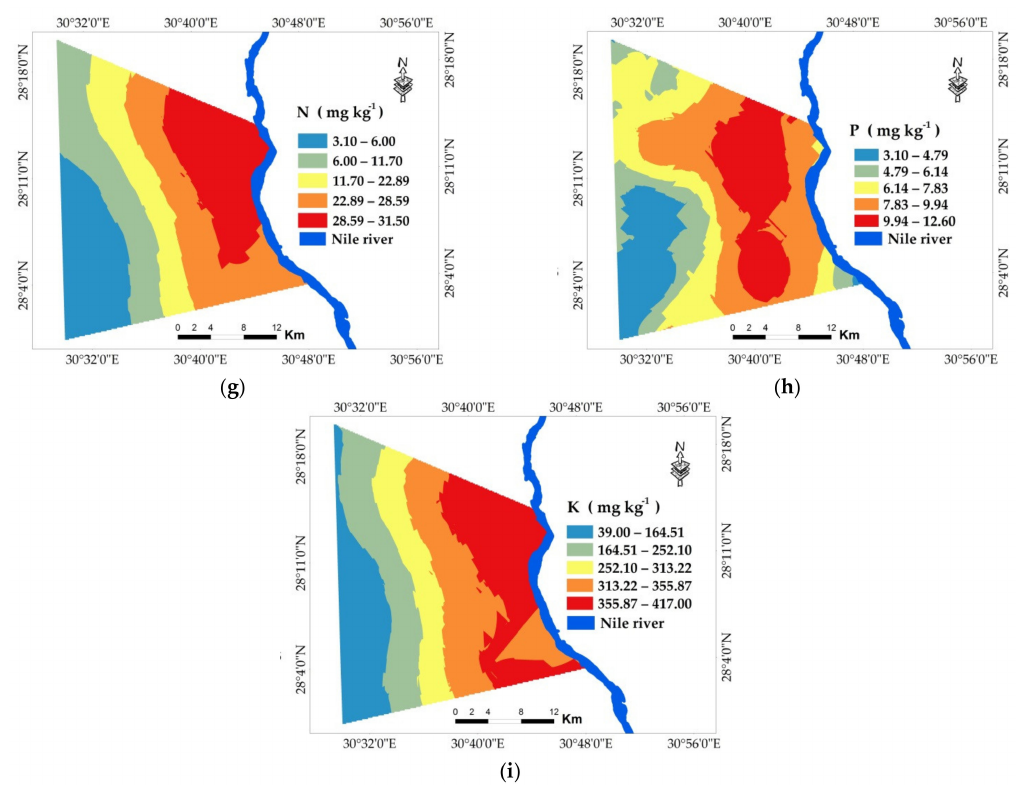
Figure 7. Interpolated maps of some mean weighted soil properties: ( a ) soil salinity (EC dSm − 1 ), ( b ) soil reaction (pH), ( c ) % of calcium carbonate (CaCO 3 %), ( d ) % soil organic matter (% SOM%), ( e ) cation exchange capacity (CEC cmolc+ kg − 1 ), ( f ) exchangeable sodium percent, ( g ) average